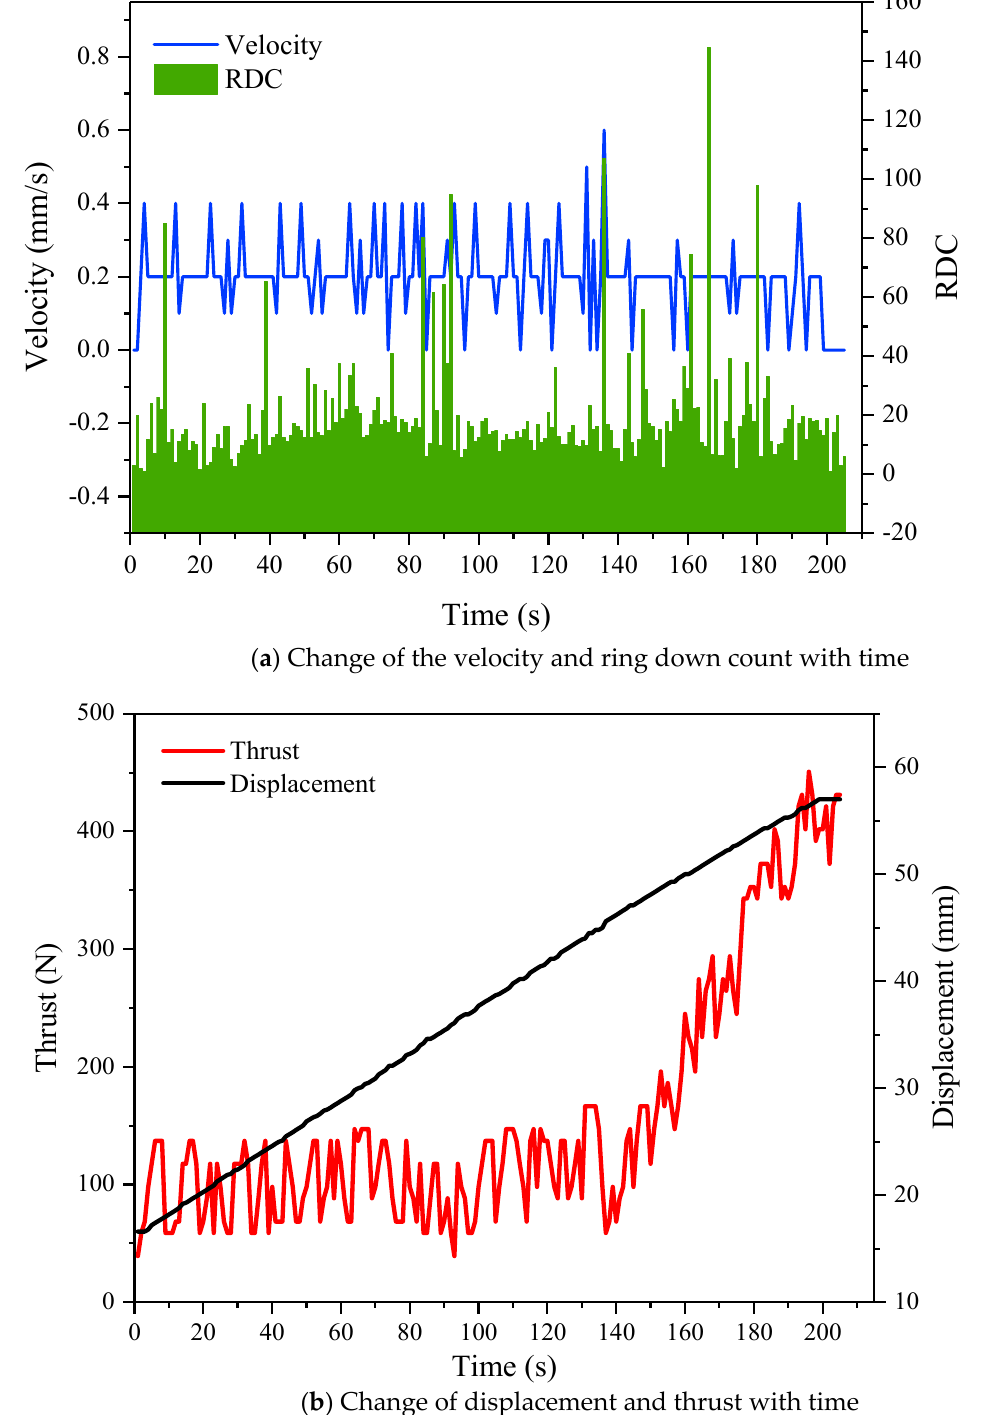
Figure 10. Precision analysis of deformation quantification by acoustic emission under the condition of constant velocity of the sliding body.